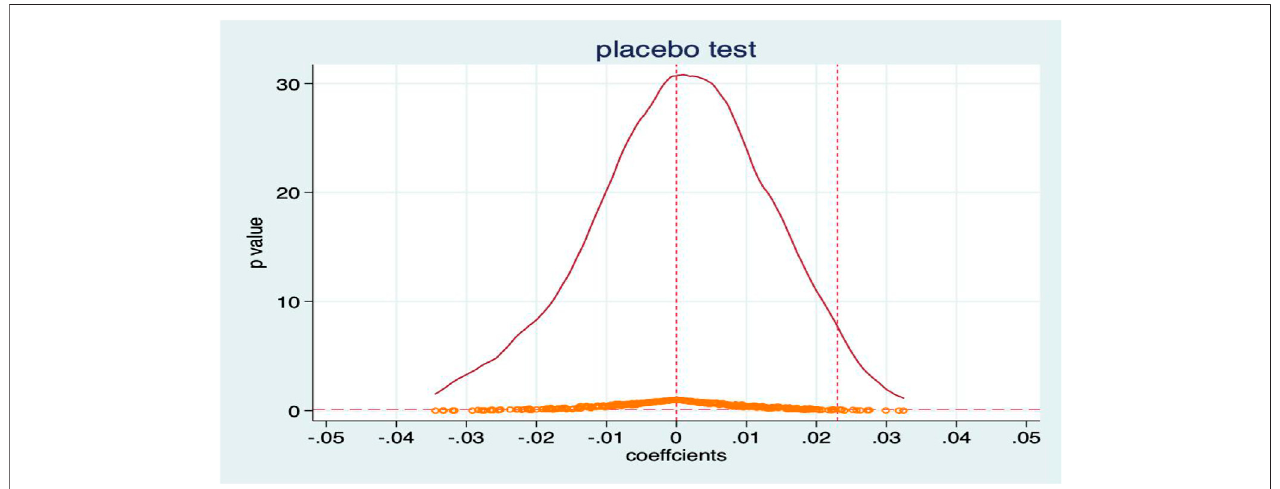
FIGURE1| PlaceboTest.Theabscissaaxisrepresentstheestimatedcoef fi cient,andtheordinateaxisrepresentsthe p -value.Thereddashedlineisthepositionof the actual estimated coef fi cient. The orange dots represent the distribution of the randomly estimated coef fi cients.